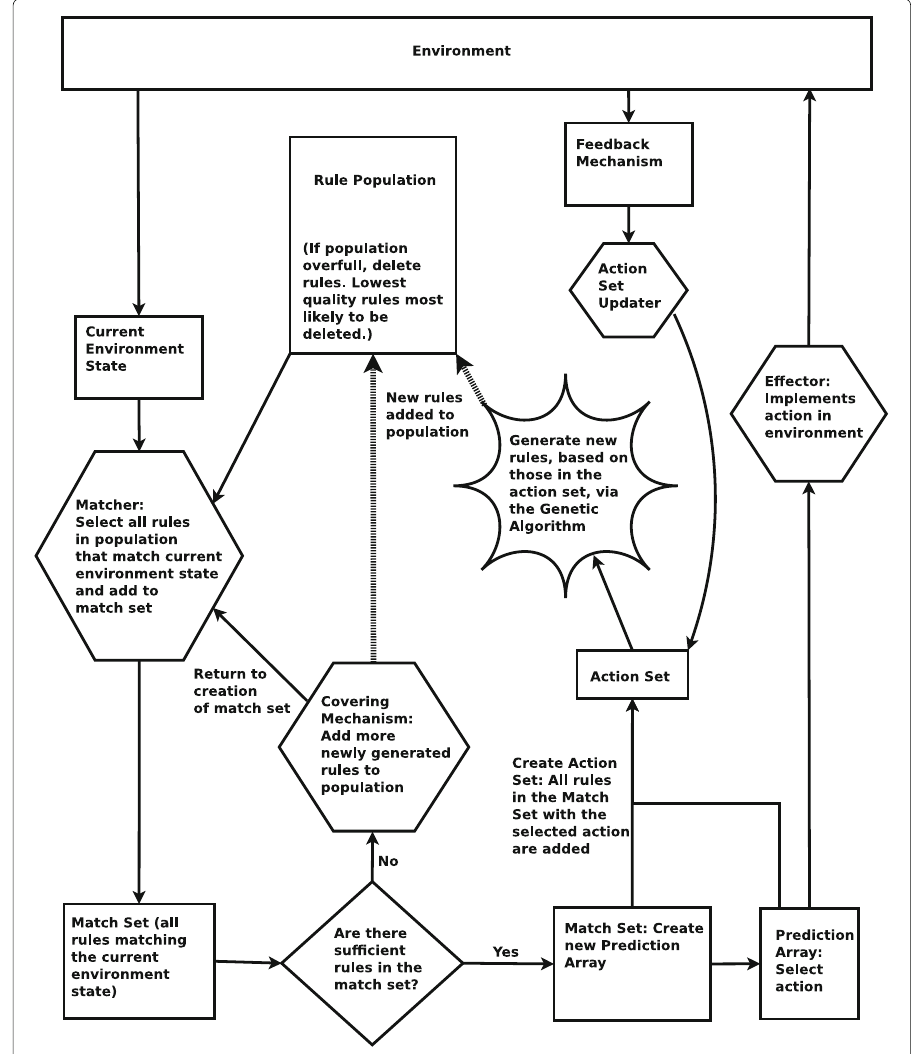
Fig. 5 Structure of an XCS classifier system. Based on (Wilson 1998) and originally shown in (Matthew R Karlsen and Sotiris Moschoyiannis: Learning condition action rules for personalised journey recommendations,